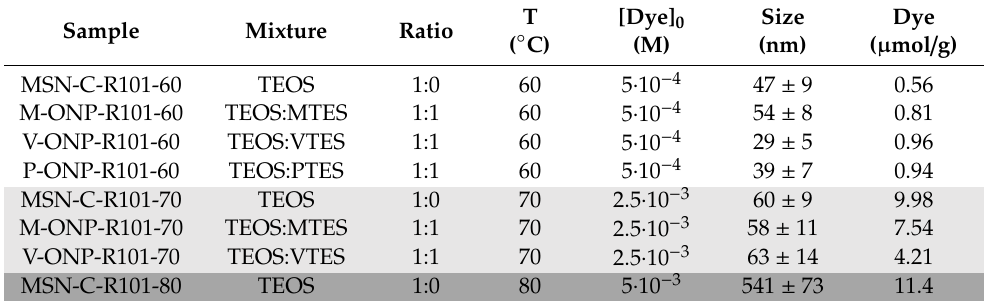
Table 2. Synthesis conditions of MSNs and Ormosil Nanoparticles (ONPs): TEOS:XTES ratio, temperature, and initial concentration of R101 in the sol-gel mixture. Average size of nanoparticles (by TEM) and the final amount of loaded dye inside the nanoparticles are